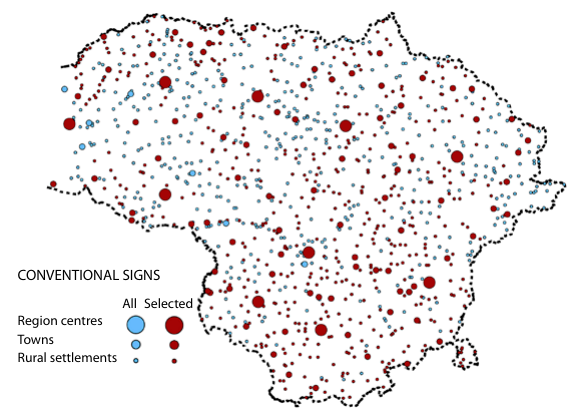
fig. 4. Plan types of the